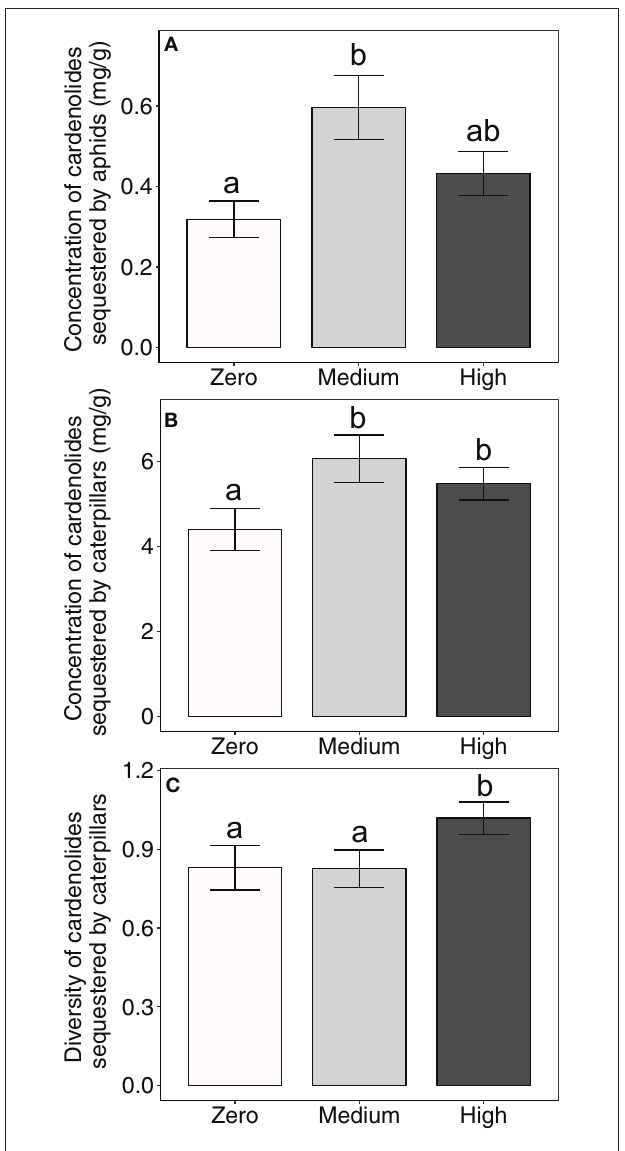
FIGURE 1 | Effects of AMF inoculum availability on the concentration of cardenolides sequestered by (A) aphid populations and (B) individual caterpillars, and on (C) the diversity of cardenolides sequestered by individual caterpillars reared on three milkweed species. Sample sizes range from 15 to 24 aphid populations ( = replicate plants) for aphid cardenolide concentrations, 39–43 individual caterpillars ( = replicate plants) for the concentration and diversity of cardenolides sequestered by caterpillars per AMF treatment. Bars display the mean ± 1 SE. Different letters indicate significantly ( P < 0.05) different means (Tukey post-hoc test of the